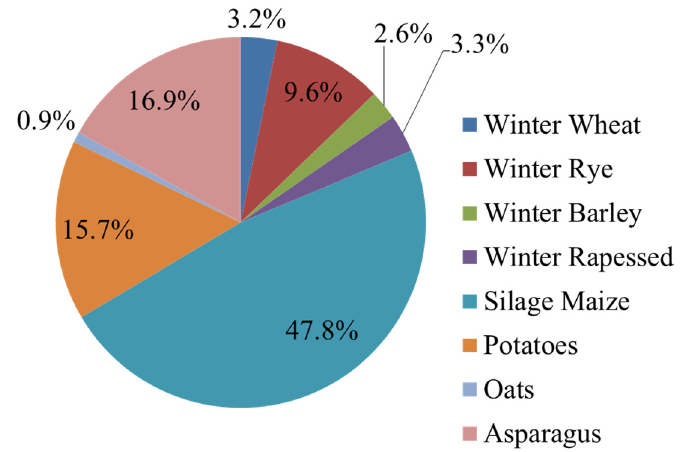
Figure 6. Share of irrigated crops in the irrigated area in the study